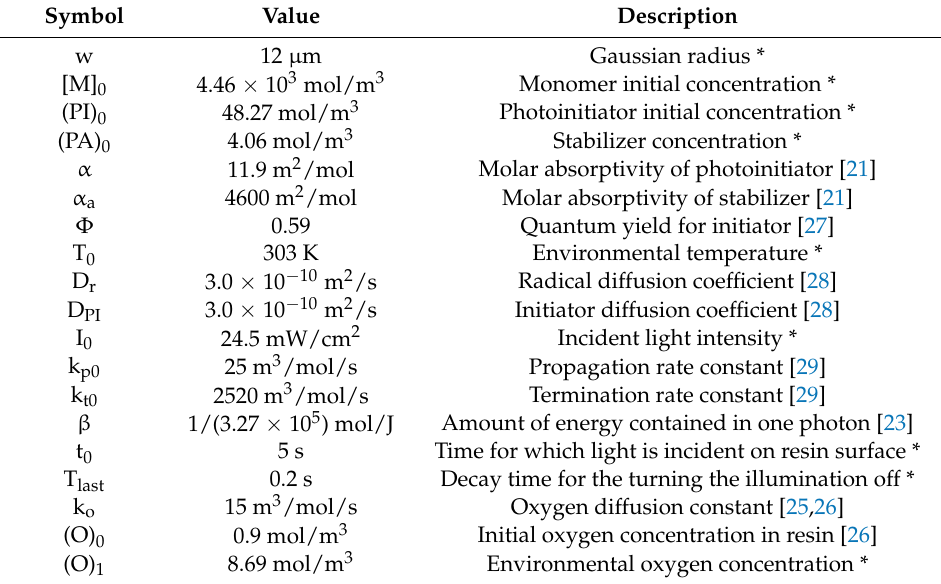
Table 2. List of P µ SL process parameters. * is from